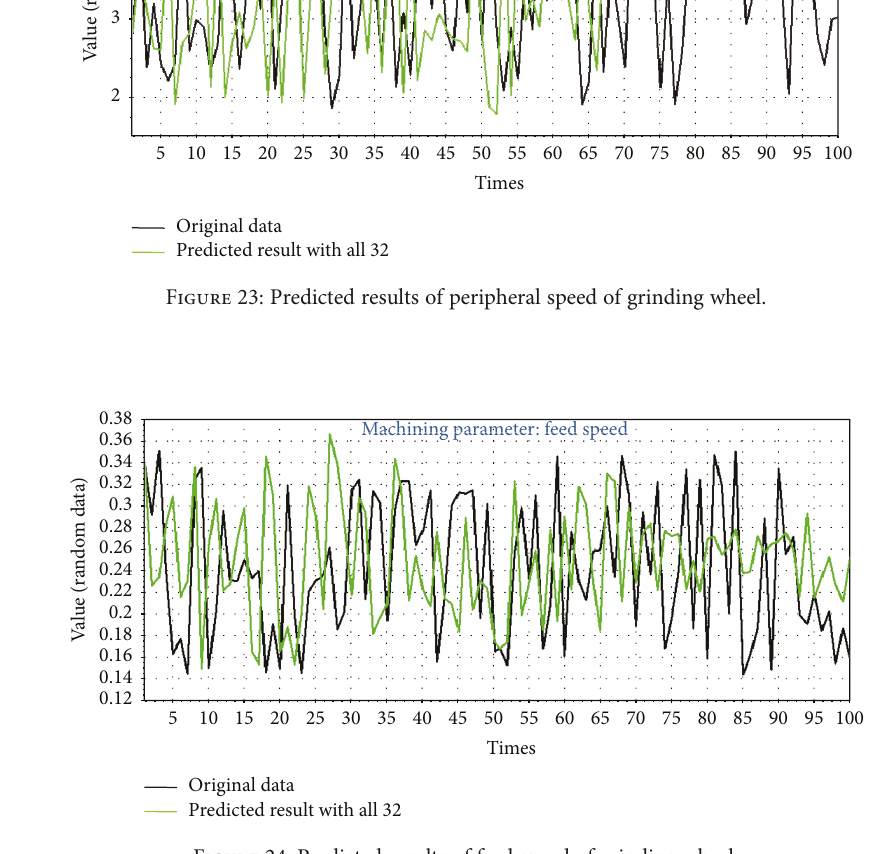
Figure 24: Predicted results of feed speed of grinding wheel.